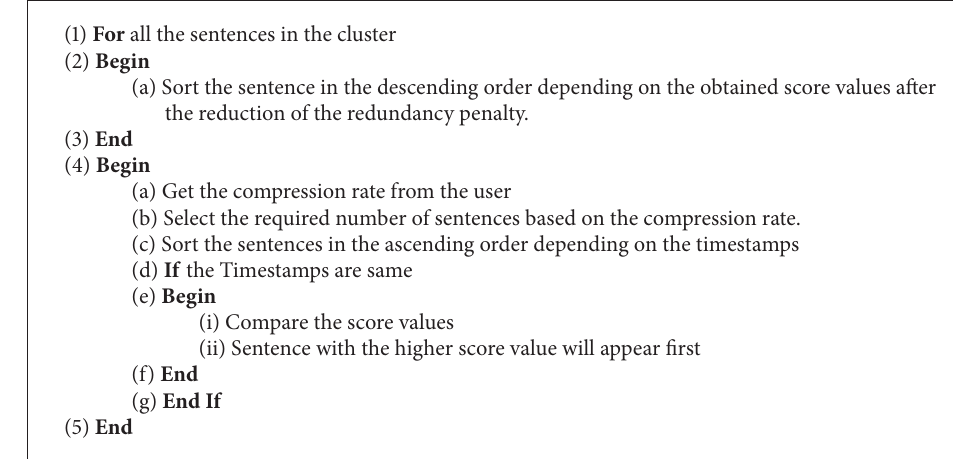
Algorithm 3: Timestamp based summary